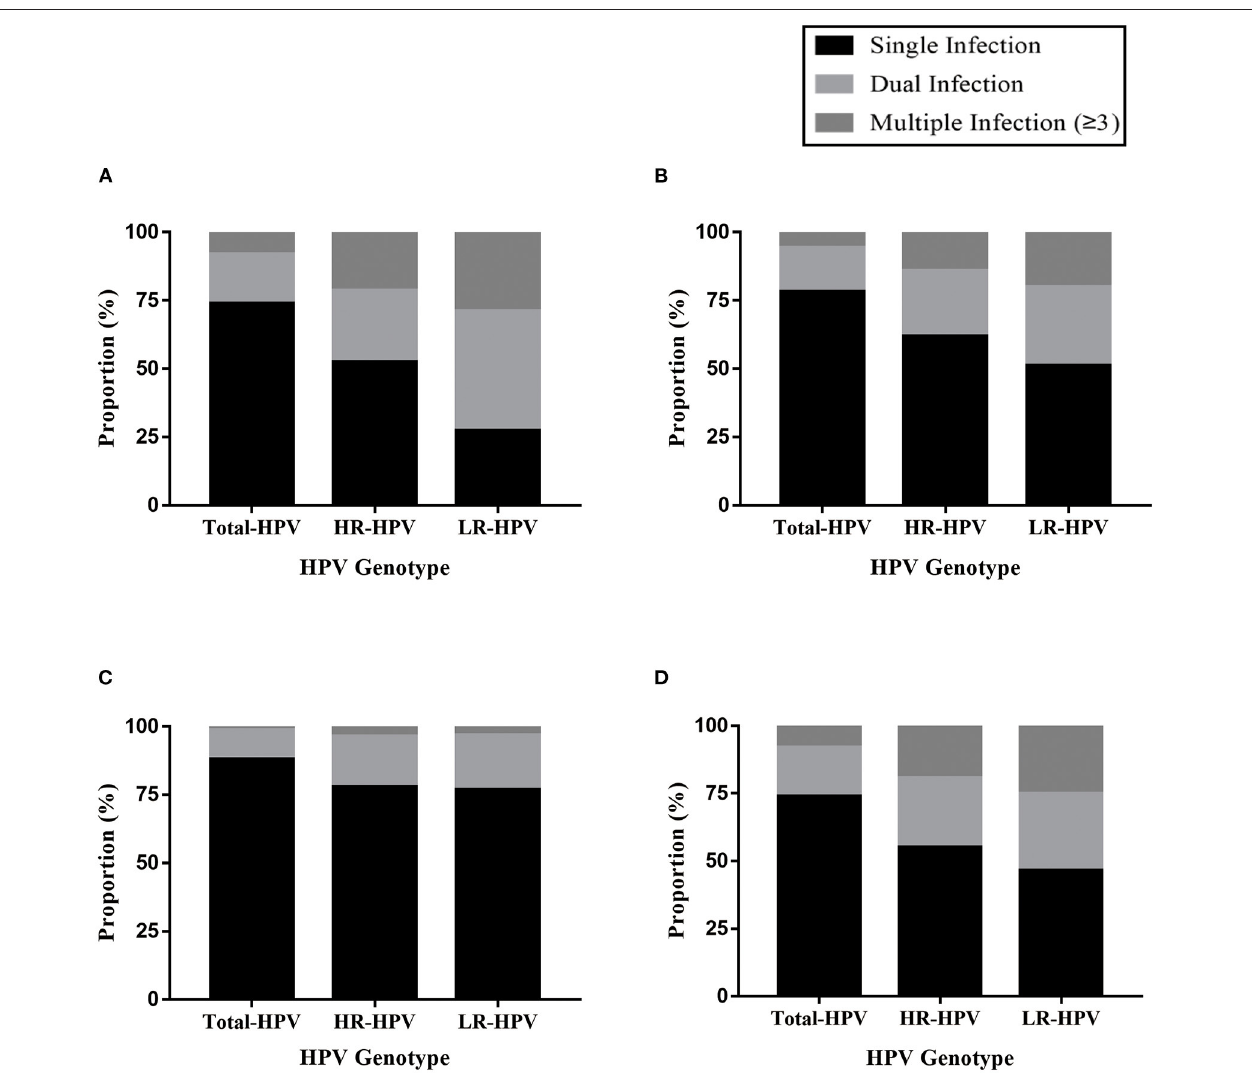
FIGURE 1 | (A) Distribution of single and multiple infections in HPV genotypes among gynecological outpatients. (B) Distribution of single and multiple infections in HPV genotypes among reproductive gynecological outpatients. (C) Distribution of single and multiple infections in HPV genotypes among physically examined population. (D) Distribution of single and multiple infections in HPV genotypes among HPV-positive cases.